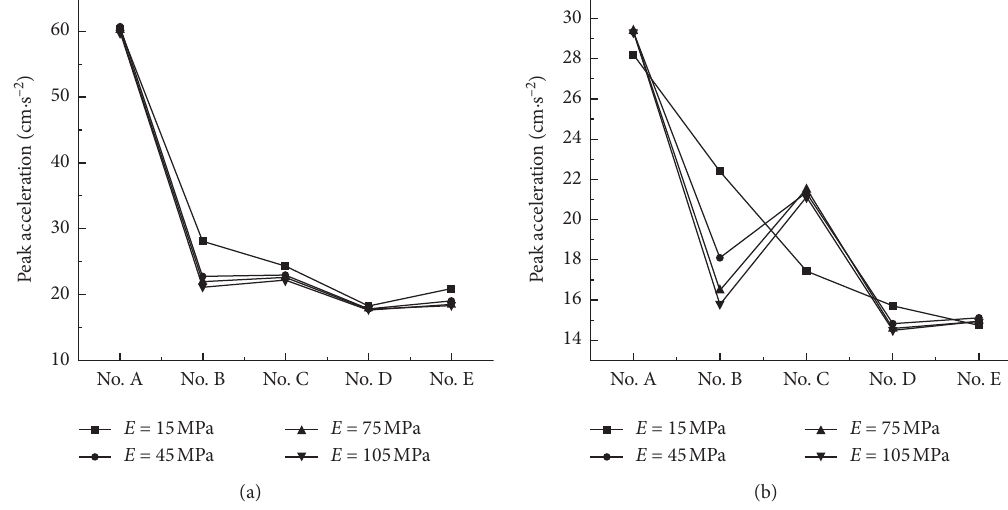
Figure 15: Influence of the elastic modulus of the second terrace on vibration. (a) Horizontal direction. (b) Vertical direction.